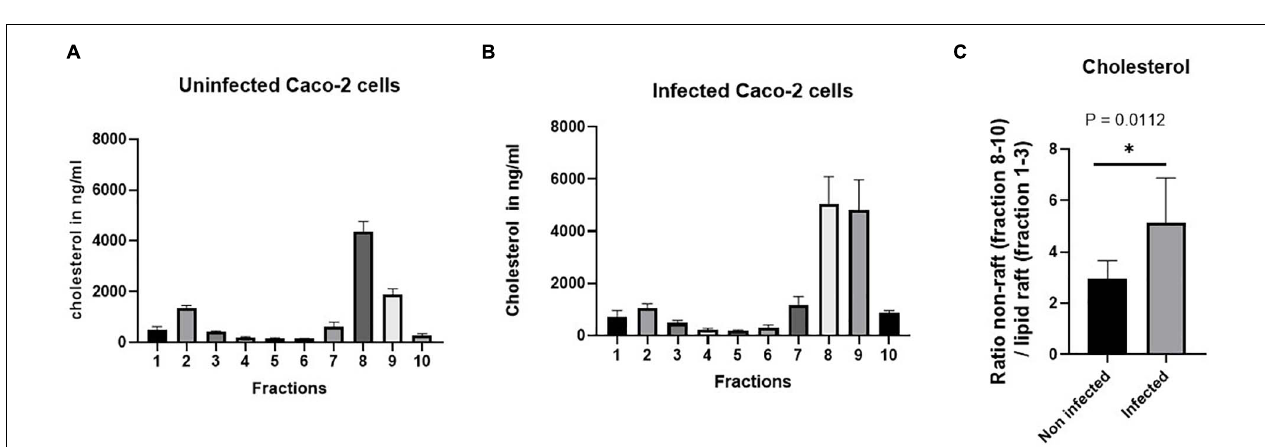
FIGURE 6 | The proportion of cholesterol. For the separation of the lipid rafts (LRs) from the non-LR fractions, sucrose gradient fractionations were used, in which the LRs are found in the top fractions (fractions 1–3) due to their low buoyant density. The level of cholesterol in the bottom three fractions (non-rafts) and in the top three fractions (LRs) in the control non-infected cells was compared with that of cholesterol from the same fractions in cells infected with S. aureus . (A,B) The raw data of the proportion of cholesterol in the control non-infected cells compared with cells infected with S. aureus . Cholesterol analysis was performed by high-performance liquid chromatography (HPLC). (C) A significant reduction (almost 50%) in the cholesterol levels was observed in the LRs of Caco-2 cells infected with S. aureus . The data represent mean ± SEM of two independent experiments with samples in duplicates or triplicates ( n = 5). Statistical significant differences are shown as * p <